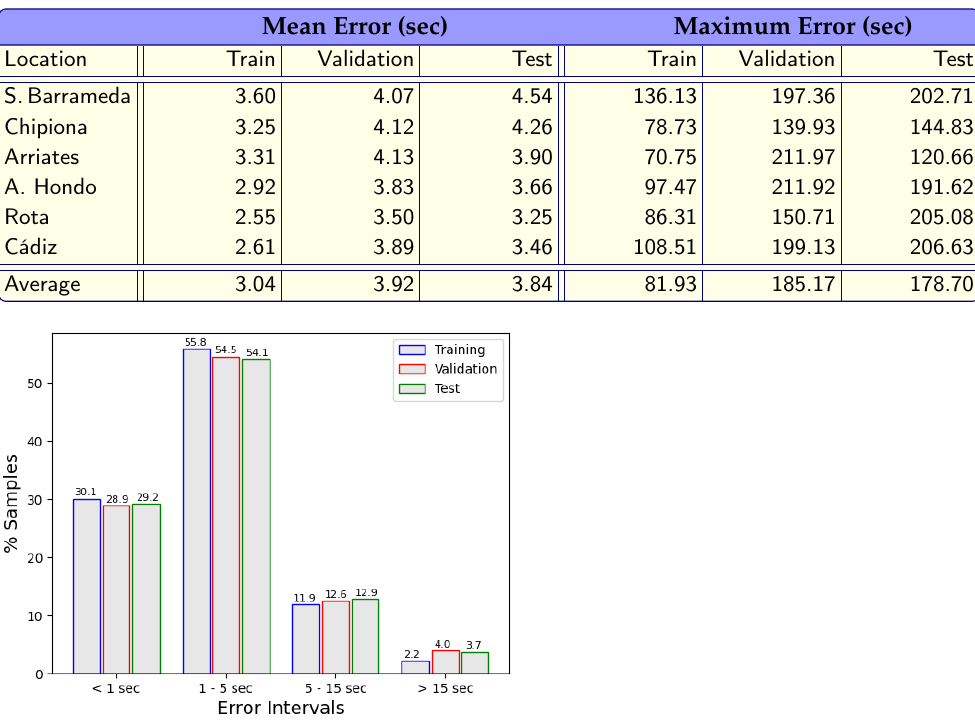
Table 18. Mean and maximum absolute errors with the ensemble model 7 for the predicted ar- rival times.